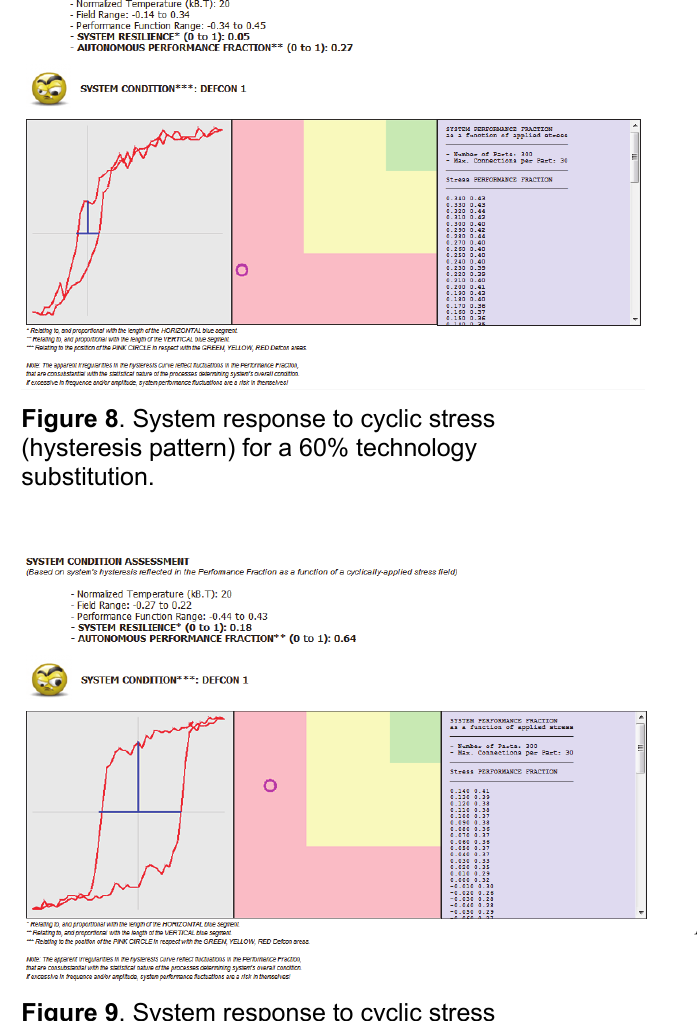
Figure 9 . System response to cyclic stress (hysteresis pattern) for a 40% technology substitution.